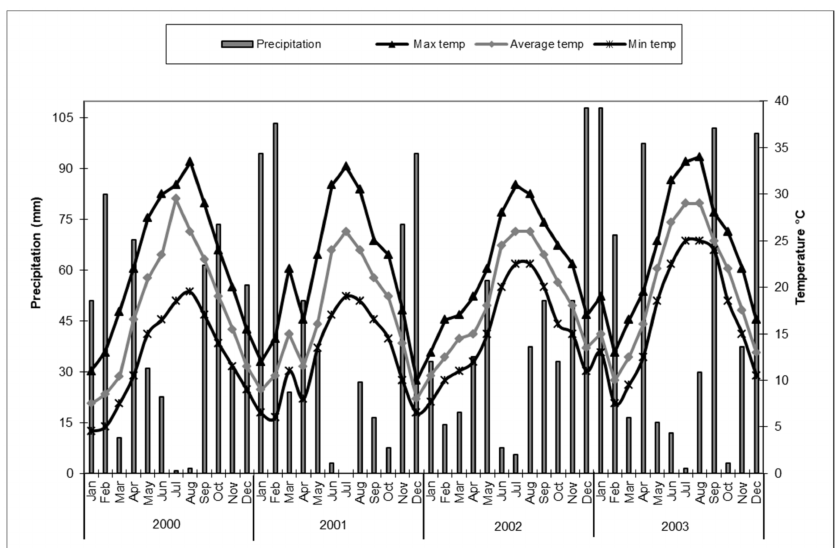
Figure 1. Total rainfall (mm) and mean temperature ( ◦ C) trends per month (SIAS) detected in the surveyed field of Citrus spp. in Sicily (Italy) from January 2000 to December